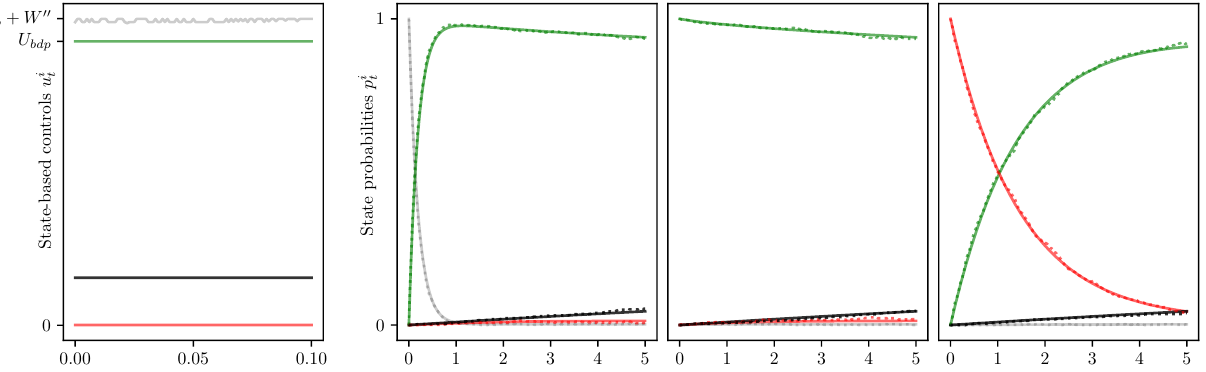
Figure 6. State-based control ( left ) and state occupation probabilities for three initial states: X 0 = e 1 , X 0 = e 2 , X 0 = e 3 ( right ).